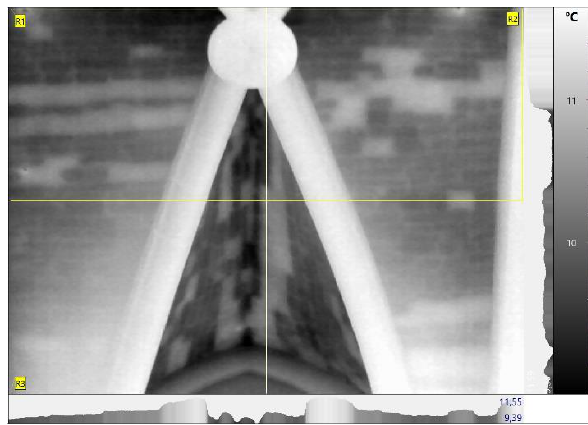
Figure 8: Thermogram of the southern transept’s vaulting with heterogenous masonry